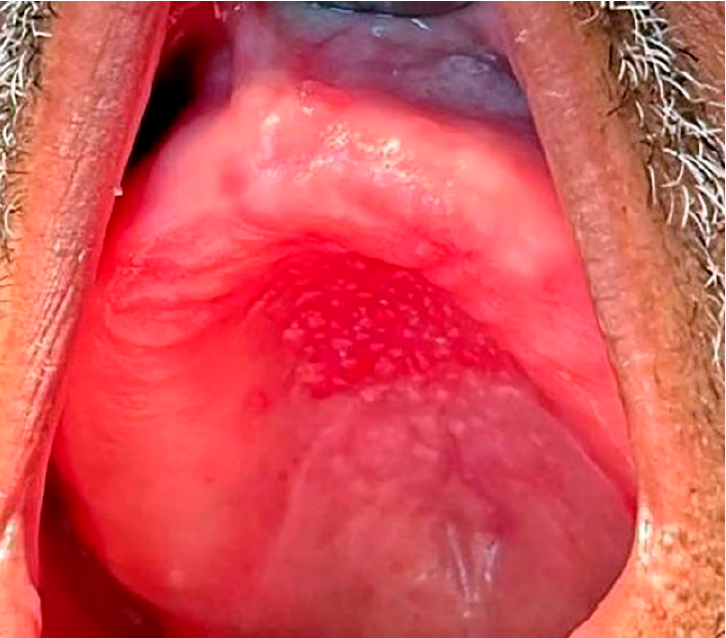
Figure 4. Inflammatory Papillary Hyperplasia in a patient with an upper full denture, the denture- bearing mucosa shows a granular appearance.